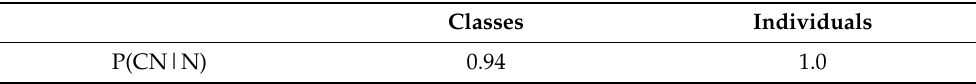
Table 2. Estimated probability that a “no correspondence” answer is correct.